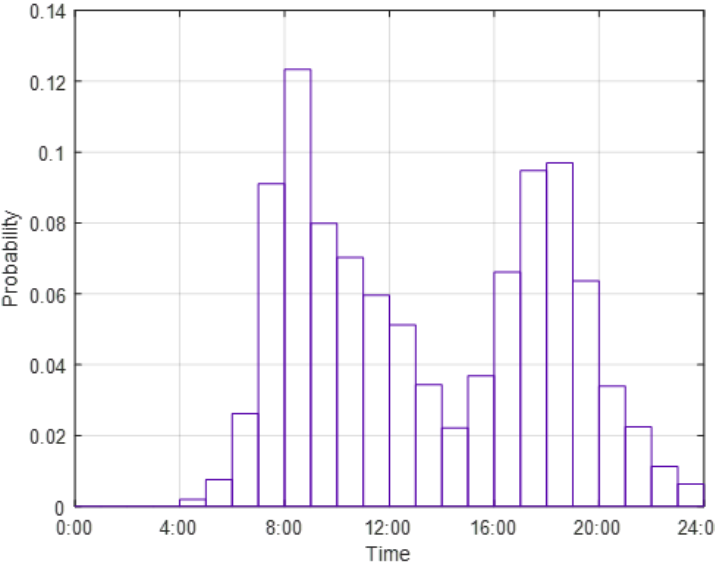
Figure 3. The probability distribution of arrival time at XFC stations.